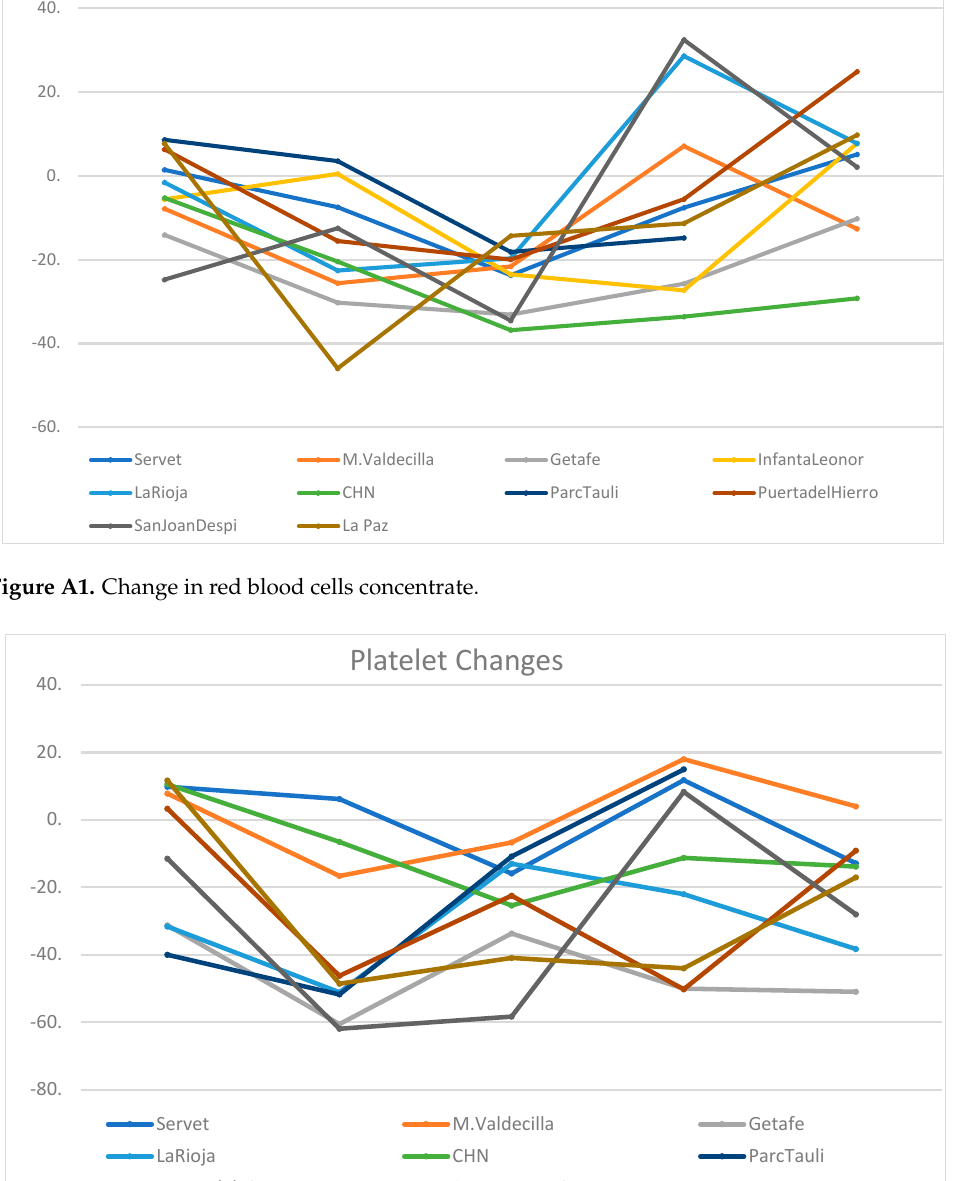
Figure A2. Platelets (excluding Hospital Infanta Leonor due to an “outlier” result of an increase of 310% in Period 0).